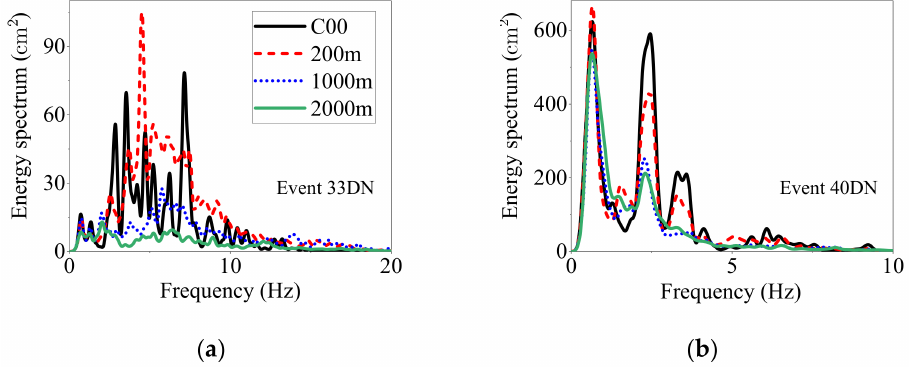
Figure 20. Smoothed average spectra of different loops for ( a ) Event 33DN and ( b ) Event 40DN.